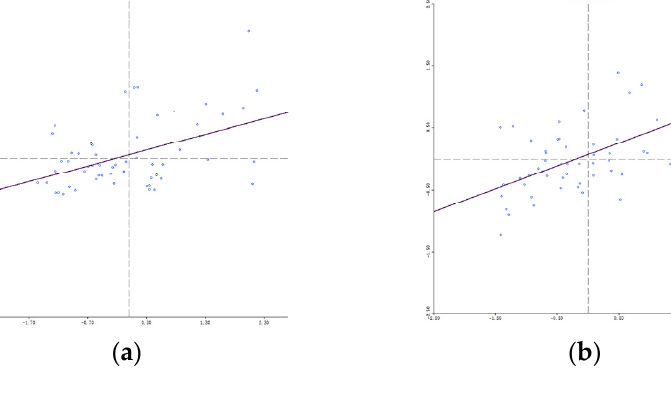
Figure 1. Moran scatter plot of the overall level of rural tourism land in the study area in 2021 ( a ), 2015 ( b ), 2009 ( c